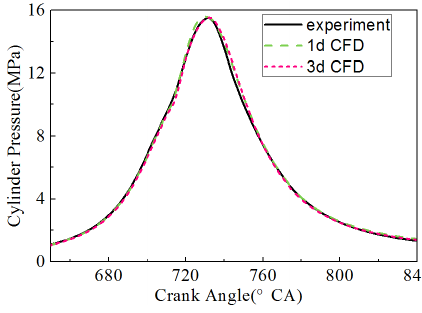
Figure 6. In cylinder pressure curve.